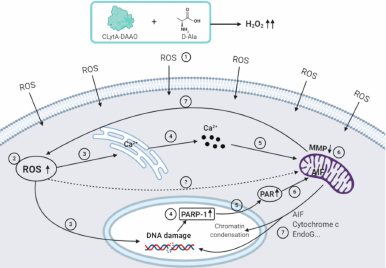
Figure 11. The general mechanism of cell death induced by CLytA-DAAO. The reaction catalyzed by CLytA-DAAO when oxidizing D-Ala generates H 2 O 2 , a potential reactive oxygen species (ROS) producer. ROS enters the cell (1) and its accumulation inside the cell (2) induces a calcium release from the endoplasmic reticulum (ER) (3) to the cytosol (4) through IP3R channels and direct damage to DNA (3). The calcium released is directed to the mitochondria (5), causing mitochondrial membrane depolarization (6) and, consequently, promoting additional ROS production (7). In turn, the MMP decrease is associated with the exit of proteins from the mitochondria, which finally causes DNA fragmentation and chromatin condensation, such as AIF, cytochrome c, Endo G, etc. (7). On the other hand, when the ROS-induced DNA damage is very high, there is an overactivation of PARP-1 (4), which leads to an accumulation of the PAR polymer in the cytosol (5), which also causes AIF translocation from the mitochondria to the nucleus (6). The results obtained in IMIM-PC-2 suggest that, in addition, ROS are capable of acting directly on the mitochondrial membrane by an unknown mechanism (?), since depolarization is produced but calcium does not play a role in cell death (Created with